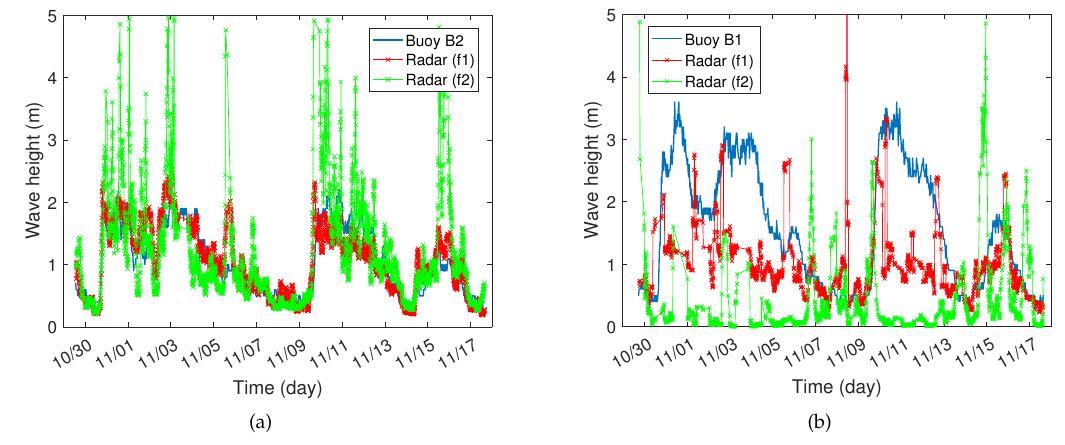
Figure 11. Wave height comparison between single-frequency radar (red dots- f 1 and green dots- f 2 ) and buoys (blue lines): temporal sequence at distance of ( a ) 15 km and ( b ) 70